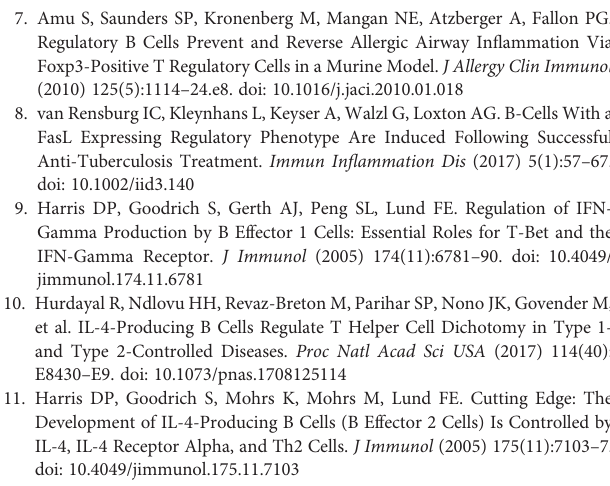
Supplementary Figure 2 | Gating strategy for B cell subset identi fi cation in chronic Mtb -infected lungs of mice. Supplementary Figure 3 | Gating strategy for various immune cell populations in chronic Mtb -infected lungs of mice. Supplementary Table 1 | The list of antibody fl uorophores and clones. Supplementary Table 2 | The list of primer sequences used for